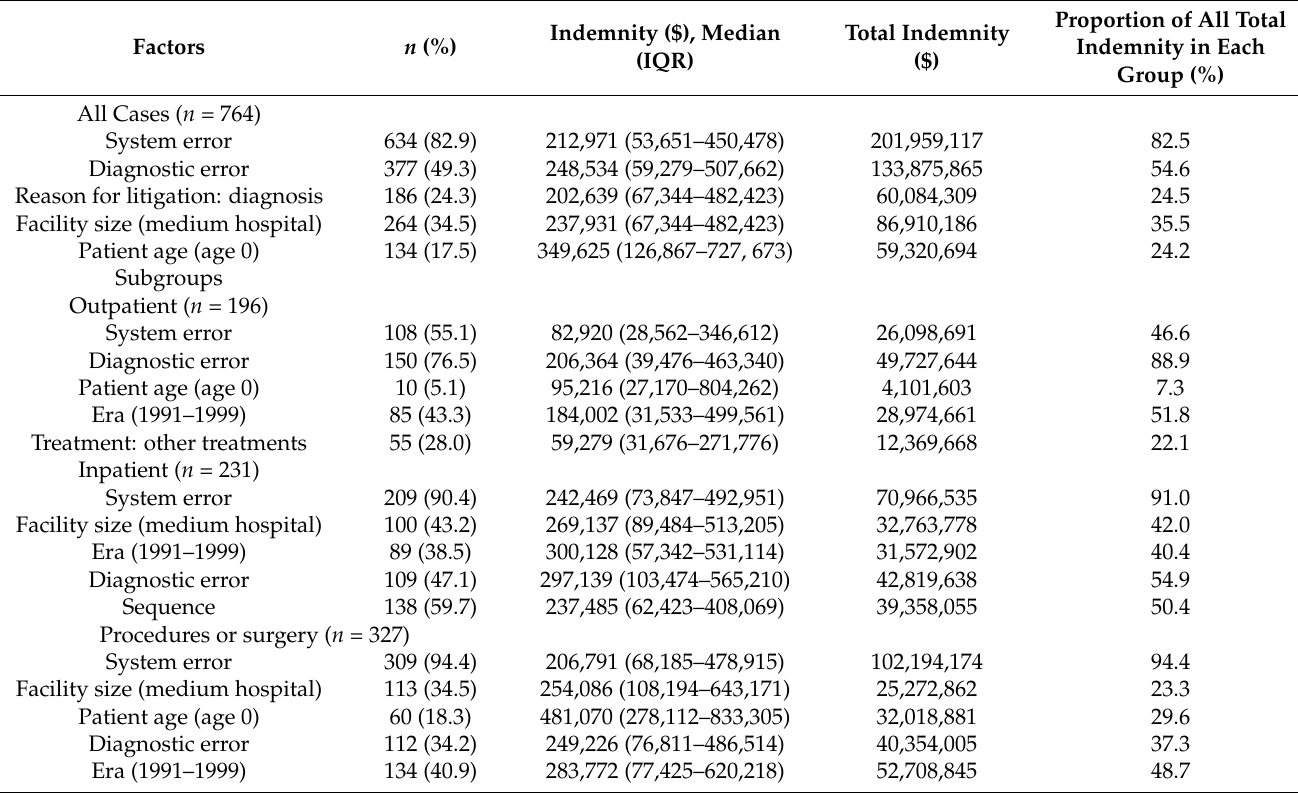
Table 4. Impact of the top five predictive factors on medical doctor loss (accepted